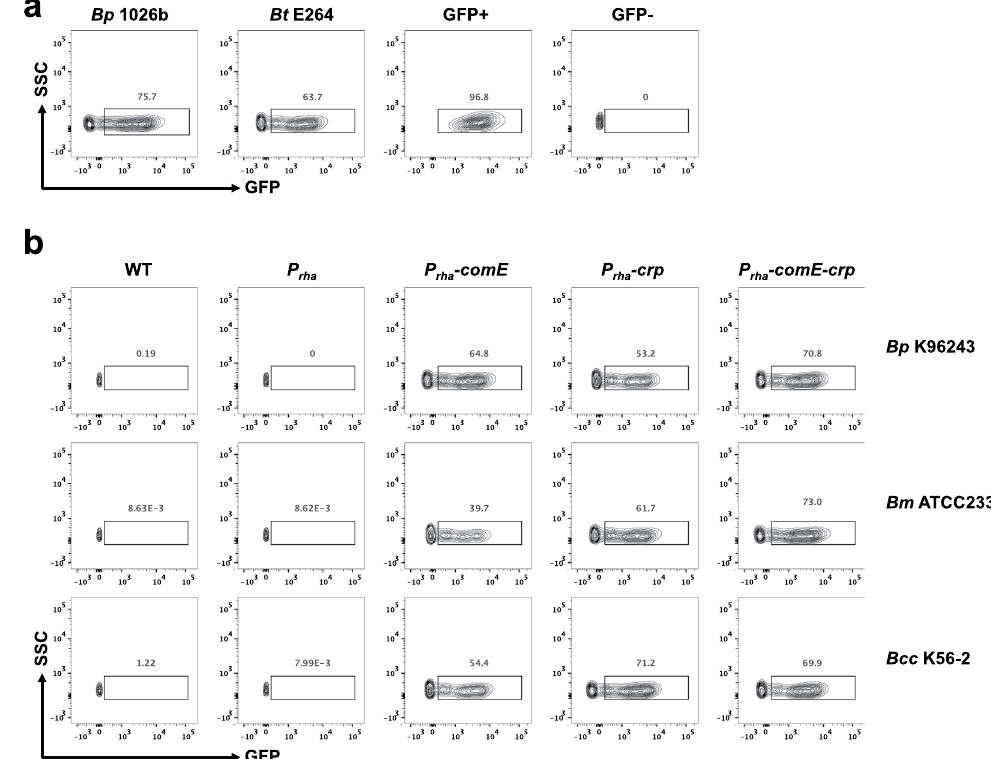
Figure 2. Linear gfp DNA uptake assay of strains expressing comE , crp , or comE-crp . For all plots side scatter (SSC) is plotted against GFP fluorescent intensity (GFP). (a) Naturally competent Bp 1026b and Bt E264 show 63–75% of cells expressing GFP after incubation with gfp . E . coli constitutively expressing gfp (GFP + ) shows 96.8% of cells expressing GFP in contrast to wildtype E . coli (GFP-) showing no GFP expression. (b) Wildtype (WT) and attTn7 controls ( P rha ) of Bp K96243, Bm ATCC23344 and Bc K56-2 show no GFP expression indicating their inability to uptake gfp . However, expression of comE , crp or comE-crp empowered natural competency, showing 39–73% of cells expressing